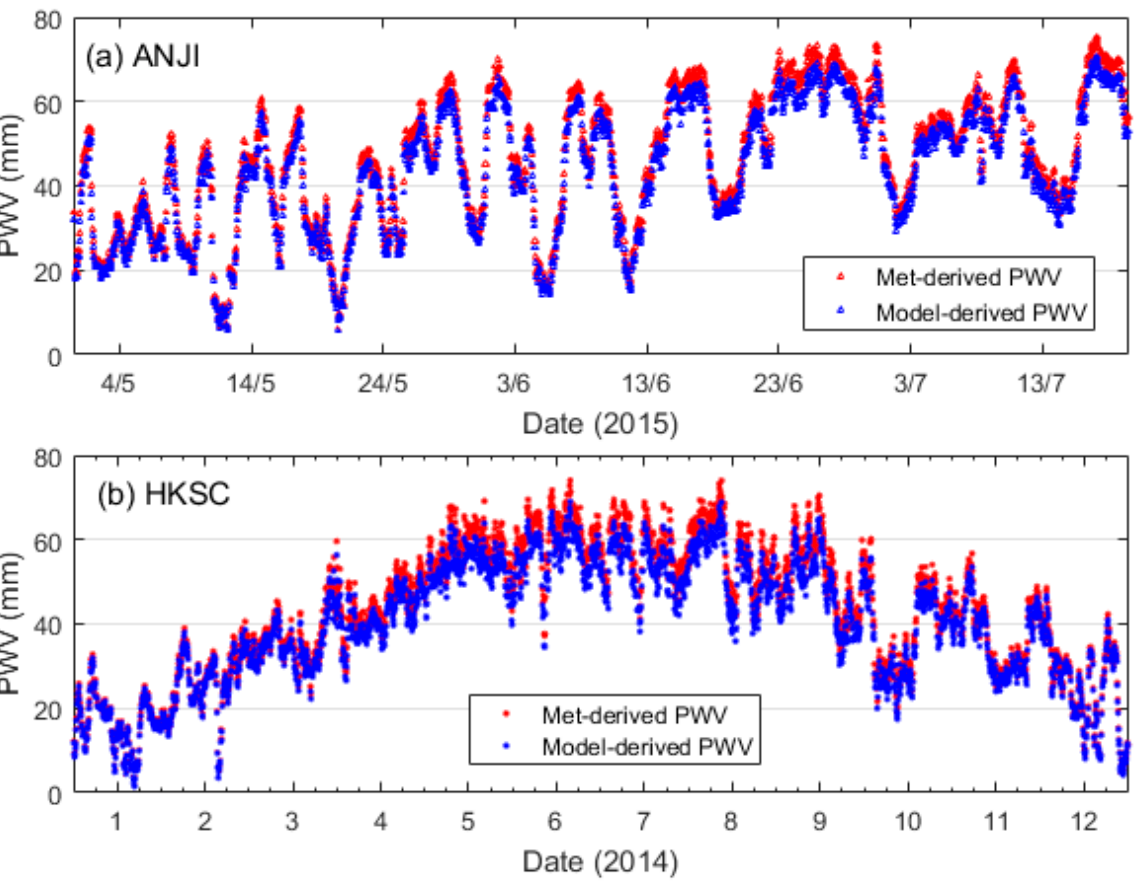
Figure 11. Comparison of the met-derived and model-derived PWV for the two selected stations, where ( a ) is the PWV comparison of ANJI station with the data from 1 May to 20 July 2015 while ( b ) is the PWV comparison of HKSC station with the data for the whole year of 2014.